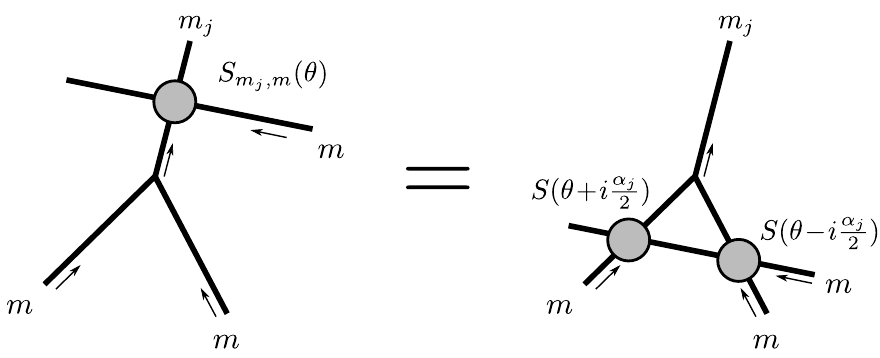
Figure 13 . Suppose we take two (to be) constituents of a bound-state and throw them very slowly at each other so that they travel (almost) parallel to each other in space-time until they are close enough to feel each other and thus form the bound-state. Now suppose we want to scatter a fundamental particle with this bound-state as indicated on the left in this (cid:12)gure. This is how we would compute the left hand side of (3.3). In an integrable theory we can shift at will the position of the wave packet of this fundamental particle. So we can shift it far into the past such that it scatters instead with the constituents of the bound-state well before they were bound together as represented on the right. This leads to the right hand side of